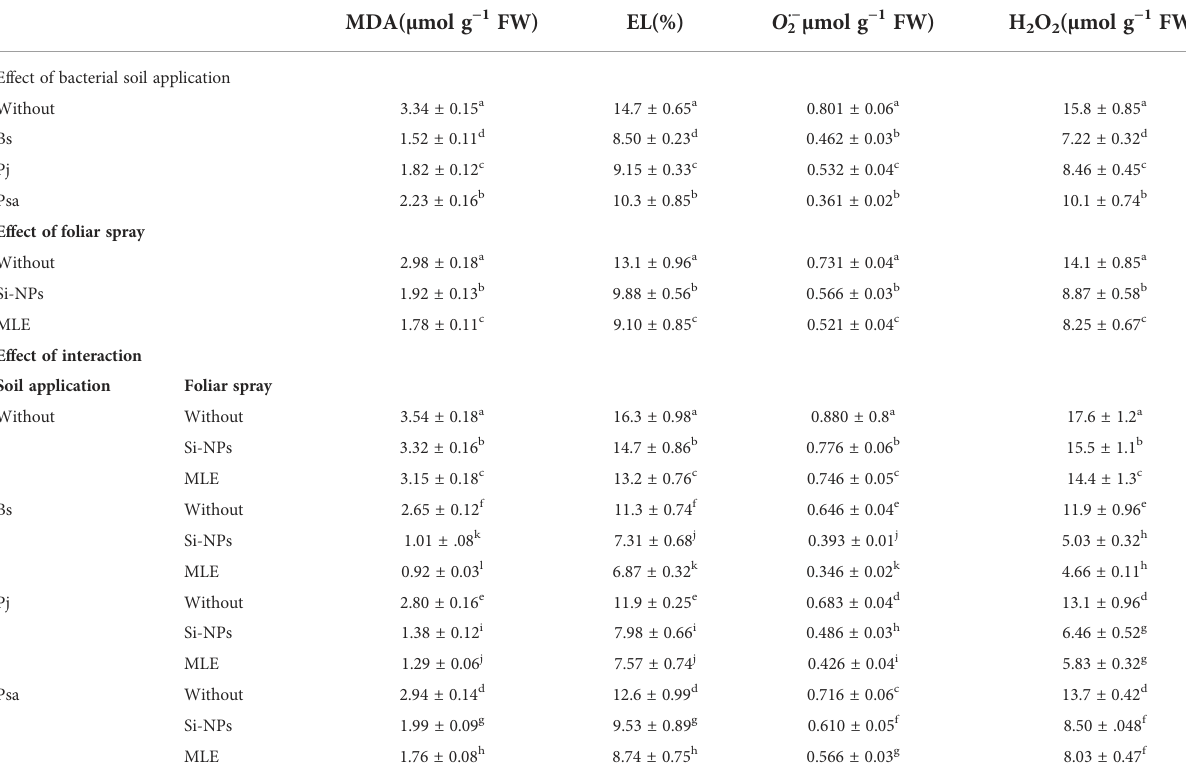
TABLE 5 Changes in malondialdehyde (MDA), electrolyte leakage (EL), hydrogen peroxide (H 2 O 2 ), and superoxide radical (O 2 ) of heavy metal – stressed spinach plant in response to bioremediation of heavy metals bacterial applied as soil inoculation and/or foliar spray with MLE or